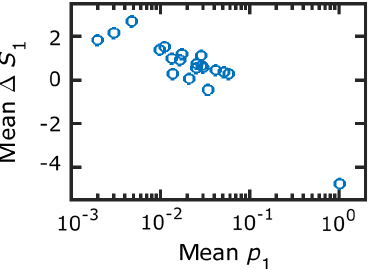
FIG. 9. Correlation between scaling exponents and genome FIG. 8. Correlation between the gene-class-specific selection plasticity values for different functional classes of genes. The coefficient and genome plasticity values. The mean inferred Δ S 1 scaling exponent strongly correlates with the genome plasticity, is plotted against the mean inferred plasticity p 1 for all functional implying that, to a large extent, genome plasticity dominates classes. The mean values are calculated by averaging over all prokaryotic genome evolution. (a) Mean plasticity across all ATGCs. For all functional classes, Δ S 1 decreases with x 1 . ATGCs is plotted against the scaling exponent. Each point However, whereas genes of low-plasticity classes are difficult corresponds to a functional class of genes. The mobilome is to acquire and losses of these genes are rare and incur a large associated with genome plasticity that is an order of magnitude selective cost, genes of high-plasticity classes are acquired greater than those of the other gene classes and is excluded from frequently, and conversely, the loss of these genes typically incur the plot. (b) The plasticity slope is plotted against the scaling only a low cost. Consequently, a strong negative correlation exponent. Similar to (a), each point corresponds to a functional between the mean selection coefficient and genome plasticity is class of genes, and the mobilome is excluded from the observed across the functional classes of genes [Spearman < 10 − 3 for all functional correlation coefficient ρ ¼ − 0 . 79 ; p val < 10 − 3 classes; Spearman correlation coefficient ρ ¼ − 0 . 77 ; p val when omitting the mobilome (X) that demonstrates extreme values of genome plasticity and selection coefficient].